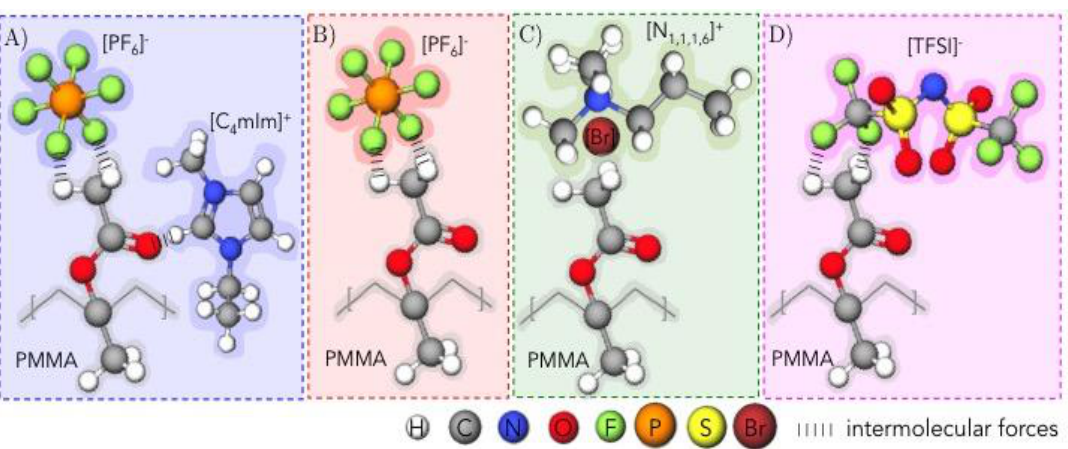
Figure 4. Schematic representations of the interactions between the methyl group of PMMA (–OCH 3 ) and ( A ) (C 4 mIm)(PF 6 ), ( B ) (N 1,1,1,4 )(PF 6 ), ( C ) (N 1,1,1,6 )(Br), and ( D ) (N 1,1,1,6 )(TFSI) ILs.